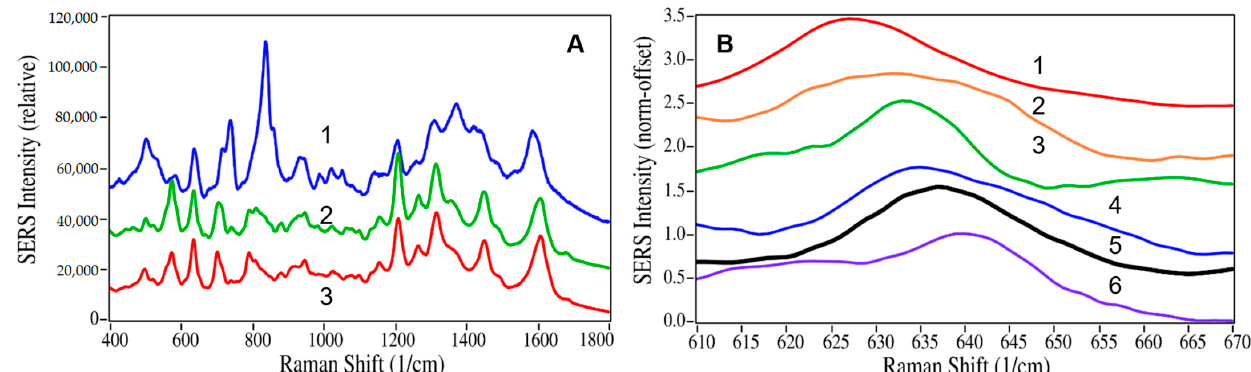
Figure 4. ( A ) Spectra of 100 µg/mL buprenorphine in water adjusted to (1) pH 7, (2) pH 6, and (3) pH 5. ( B ) Spectra of (1) heroine, (2) codeine, (3) diazepam, (4) norbuprenorphine, (5) buprenorphine, and (6) hydrocodone in the region of the buprenorphine 638 cm − 1 peak. Conditions as in Figure 1.